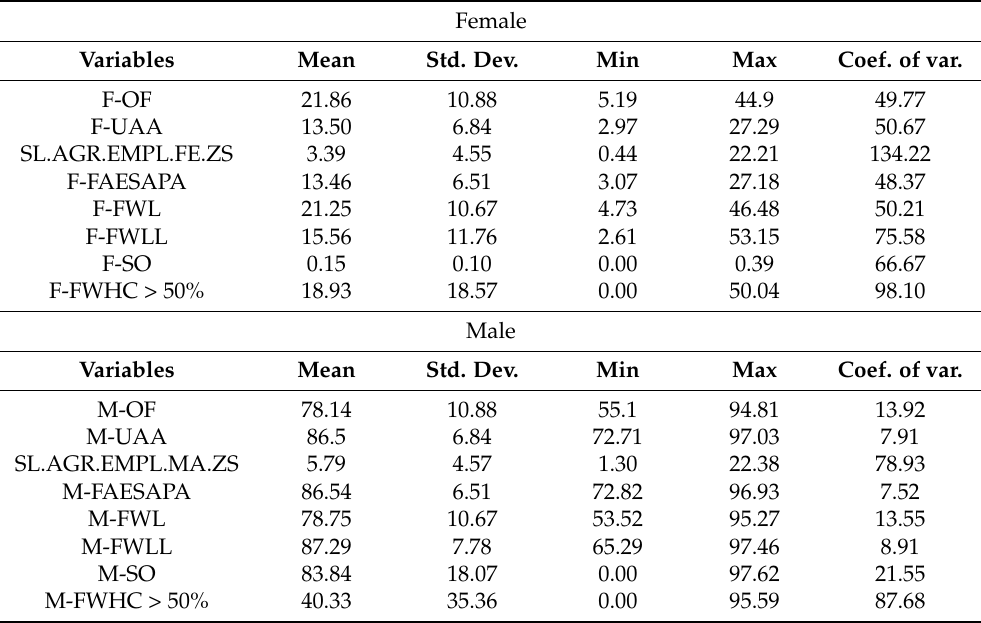
Table 4. Summary statistics of the items used in evaluating the characteristics of the agricultural sector determinants.